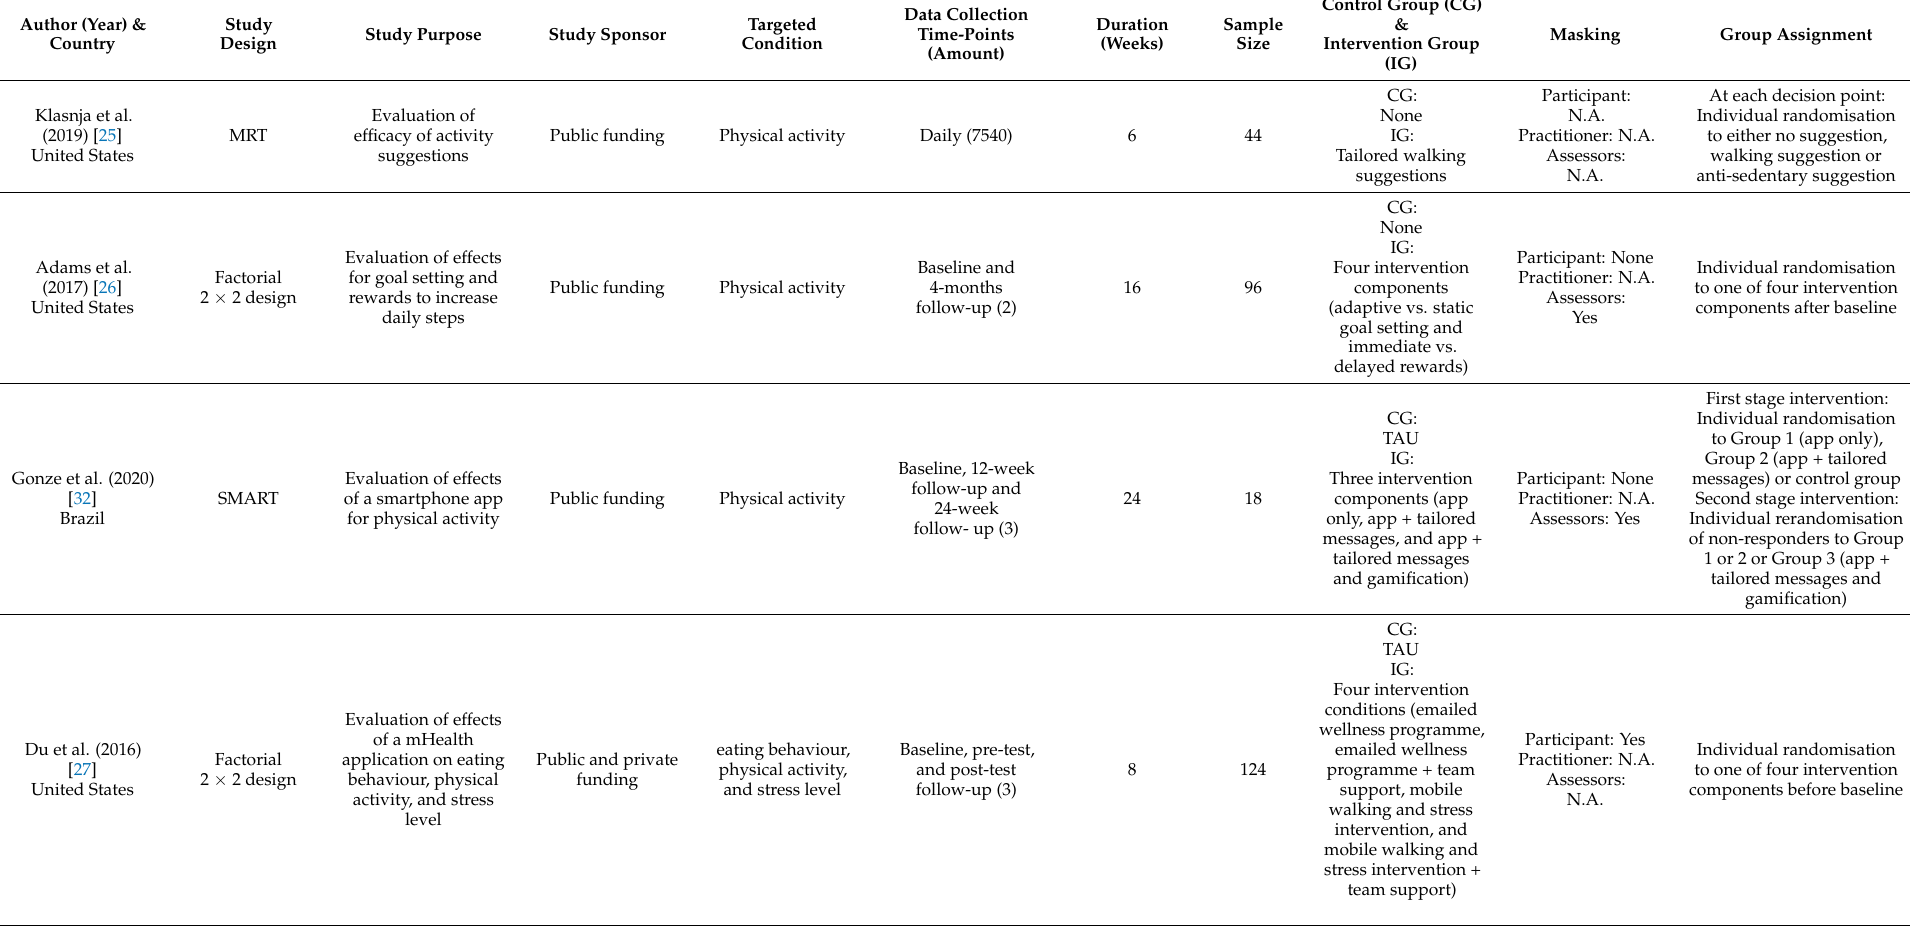
Table 2. Study Characteristics of the Included